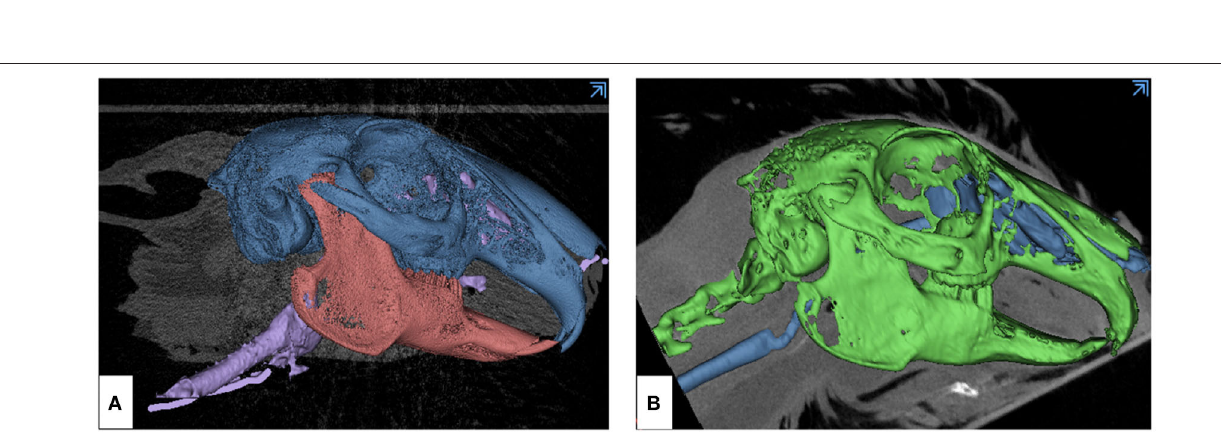
FIGURE 2 | Overview of the skeletal and mucosal masks created from DICOM imaging data of animal models using Materialize Mimics Research 21.0 segmentation software for translating the information into STL format. (A) µ CT-derived mask: blue—skull with maxilla, pink—mandible, violet—nasotracheal airway, and (B) CBCT-derived mask: green—skull with maxilla and mandible, blue—nasotracheal